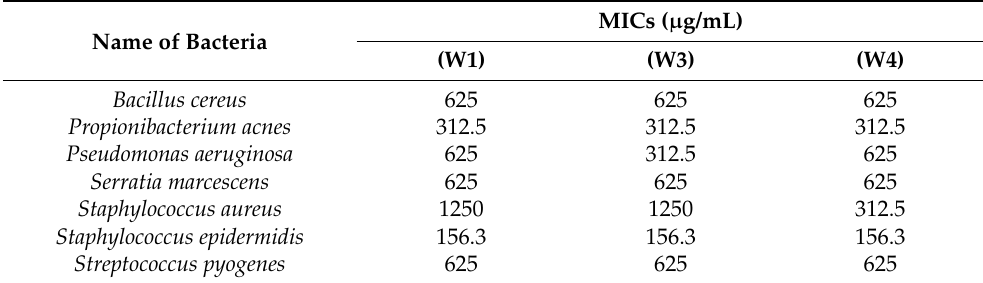
Table 12. Minimum inhibitory concentrations (MICs) of wintergreen essential oil against tested bacterial strains a .